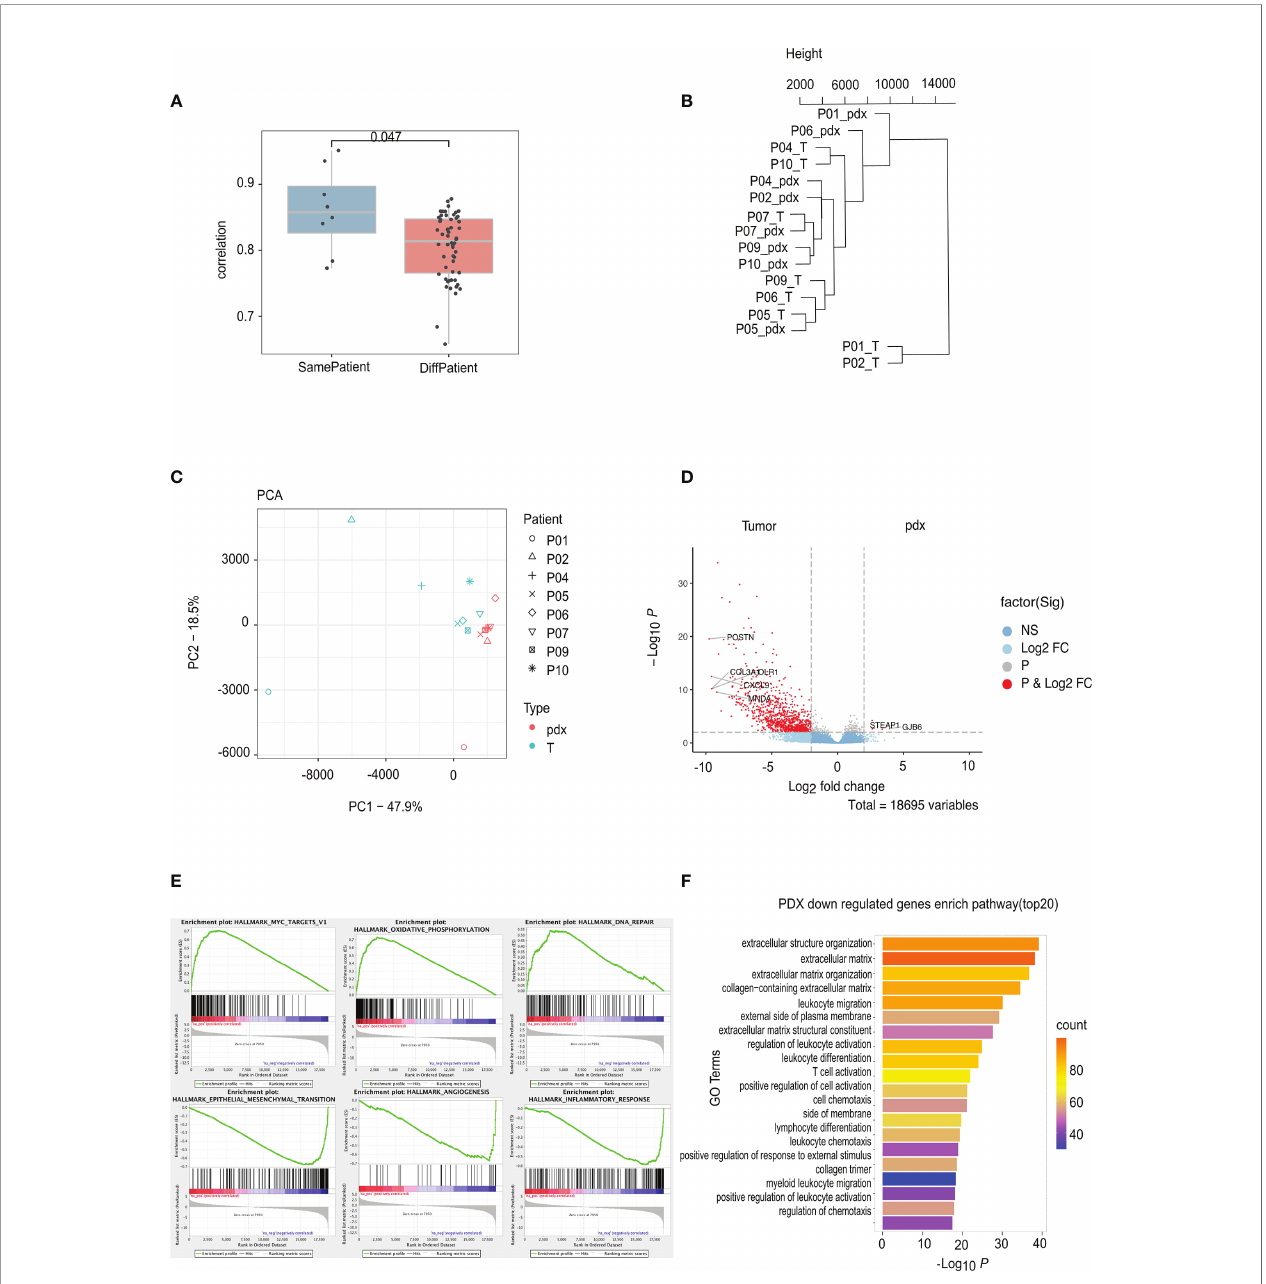
FIGURE 4 | RNA sequencing analyses of PA and PDX tumors. (A) The correlation between PA and PDX samples from the same patient is signi fi cantly higher than that between samples from different patients. (B) This phylogenetic tree depicts relationships of nine PA samples and their corresponding PDX samples at the RNA level. There is no clustering tendency of PDX and its original PA samples. (C) The technique of PCA was used to simplify the complexity in high-dimensional data of RNA sequencing and to visualize clustering of samples. PDX and PA samples are roughly separated by the dotted line, indicating an altered mode of transcription due to implantation. (D) DEGs volcanic fi gure. (E) PDX overexpressed genes clustered in Myc, oxidative phosphorylation, and DNA damage repair pathways, while low-expressed genes clustered in interstitial transformation, angiogenesis, and in fl ammatory responses. (F) GO analysis of low expression gene of PDX. PA, patient tumor; PDX, patient-derived xenograft; PCA. principal component analysis; DEGs, different expression